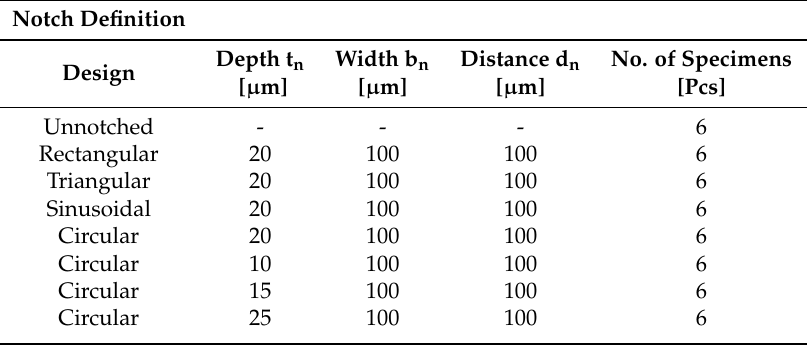
Table 1. Details of investigated notch